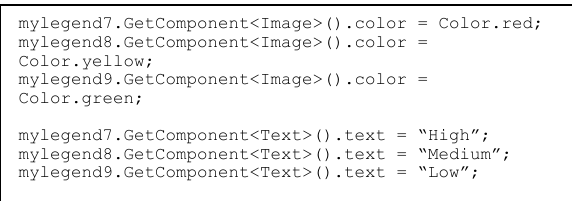
Figure 13. Fragmented script for legends colour rendering and text adding